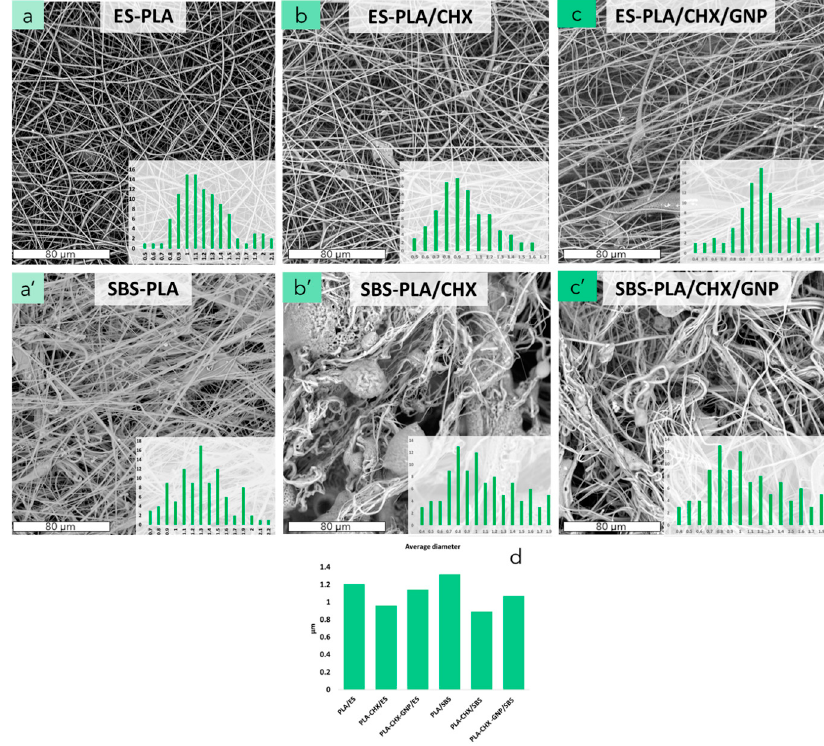
Figure 3. SEM micrographs of PLA nanofibers membranes obtained by electrospinning or solution blow spinning of ES-PLA, SBS-PLA, ES-PLA/CHX, SBS-PLA/CHX, ES-PLA/CHX/GNP, SBS- PLA/CHX/GNP ( a – c , a ’– c ’), and relative averages diameters ( d